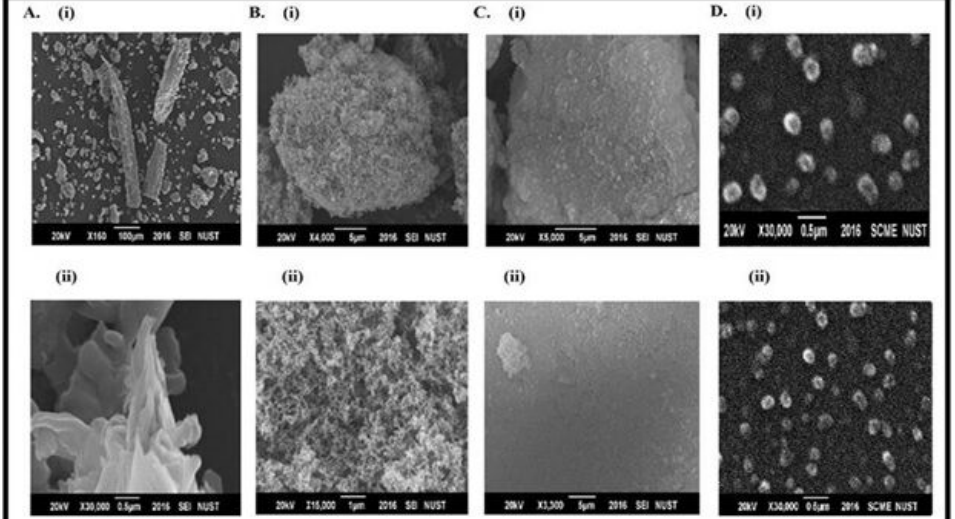
Figure 6. Scanning electron micrographs of ( A ) Pure drug, ( B ) Blank carrier, ( C ) Finasteride loaded S-SNEDDS powder and ( D ) Regenerated liquid nanoemulsion, whereas ( i ) and ( ii ) show respective SEM images at different magnifications.